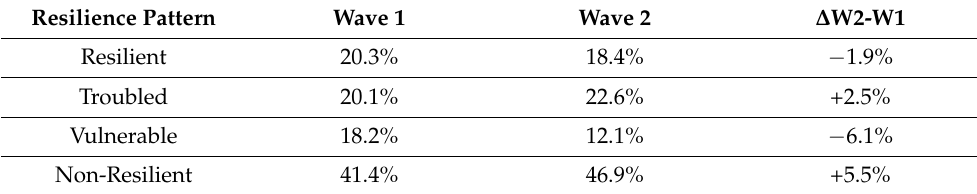
Table 5. Estimated longitudinal probabilities of the four resilience patterns by latent transition